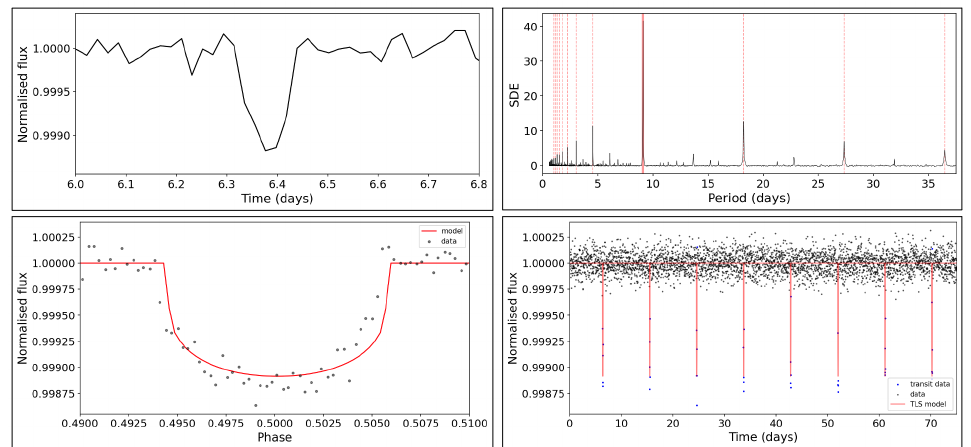
Figure 5. Results of the analysis of the light curve shown in Figure 4. Left column : In the top panel, magnification of the epoch. In the bottom panel, phase-folded light curve (black dots) and the computed Mandel and Agol shape with TLS (red line). Right column : In the top panel, SDE graphic, where the highest peak (in red) corresponds to the orbital period. In the bottom panel, the light curve (black dots) with the detected transits by TLS (blue dots) and the computed non-phase-folded transit model (red